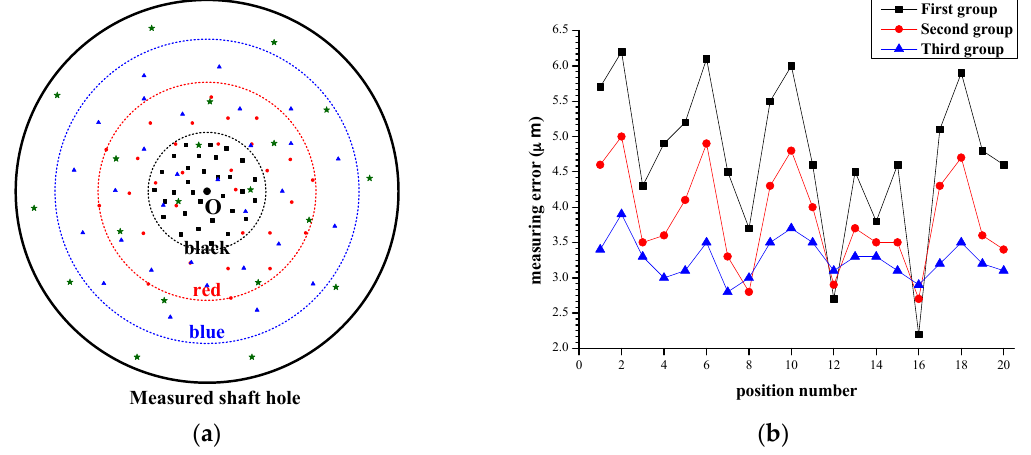
Figure 12. The influence of calibration data: ( a ) the position relationship between measuring module and measured shaft hole; and ( b ) the measuring errors using three groups of intrinsic parameters.